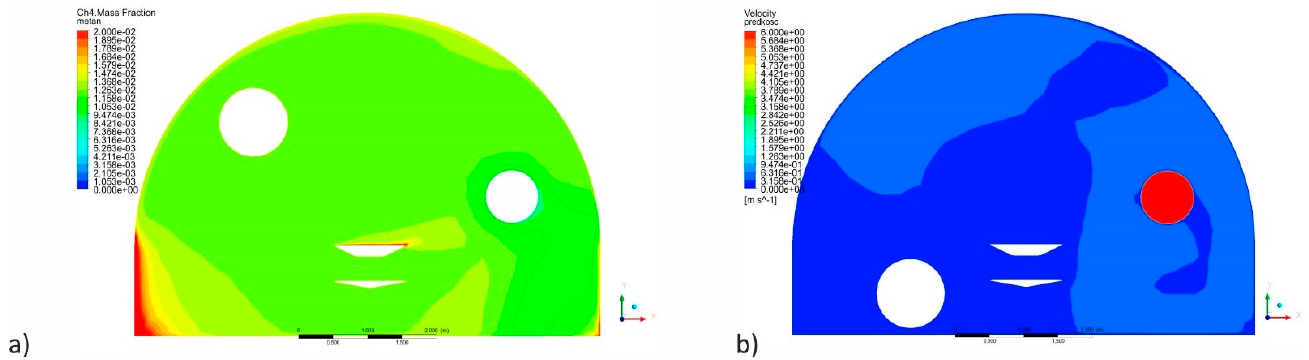
Figure 13. Cross ‐ section of roadway at the distance of 34 m to the face for the case L o = 15 m, a) methane concentration field, b) air velocity field.